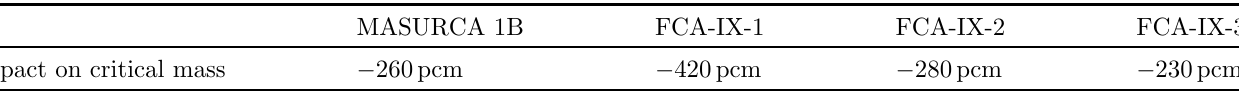
Table 3. Impact on MASURCA 1B and FCA-IX 1 to 3 critical masses when using carbon evaluation of JENDL-4.0 instead of